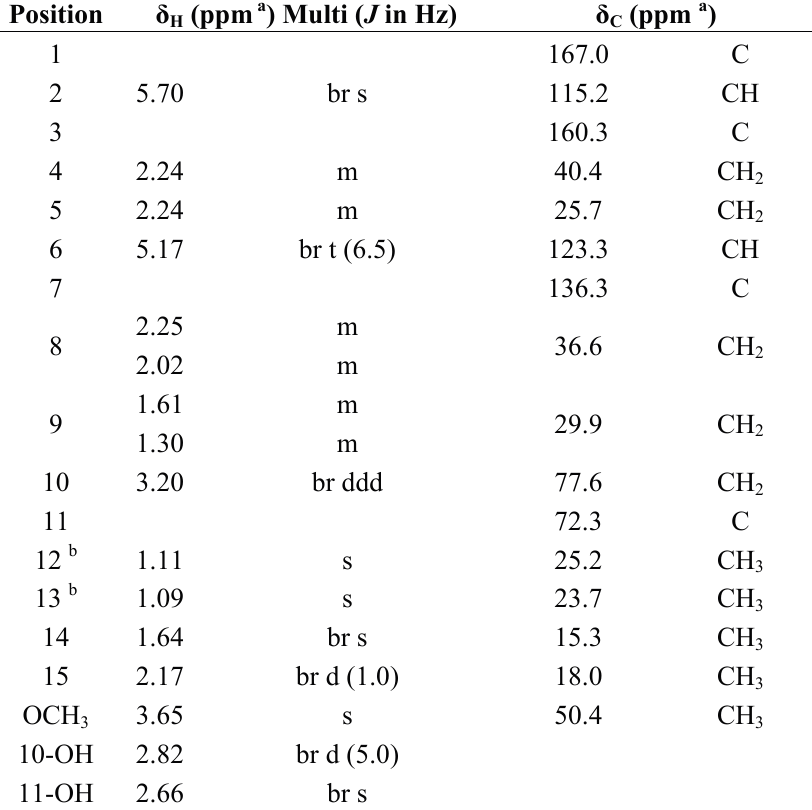
Table 1. Structure determination of